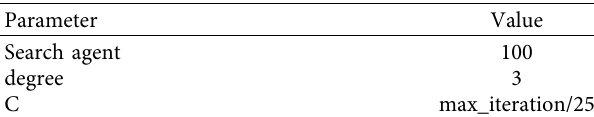
Figure 1: Flowchart of the proposed optimal NR algorithm by HBO. Table 2: HBO